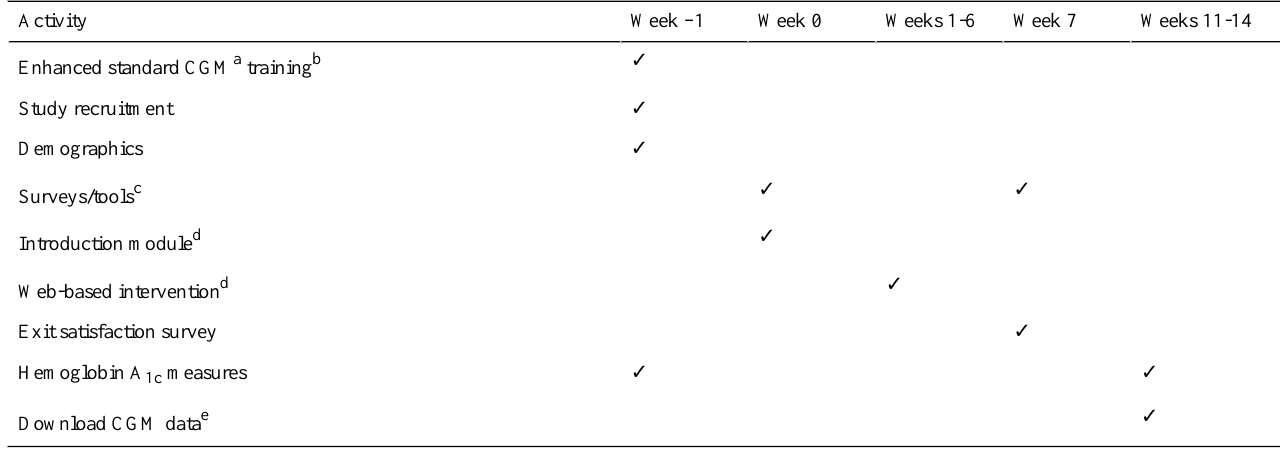
Table 1. Study activity timeline demonstrating activities over the 3-month study